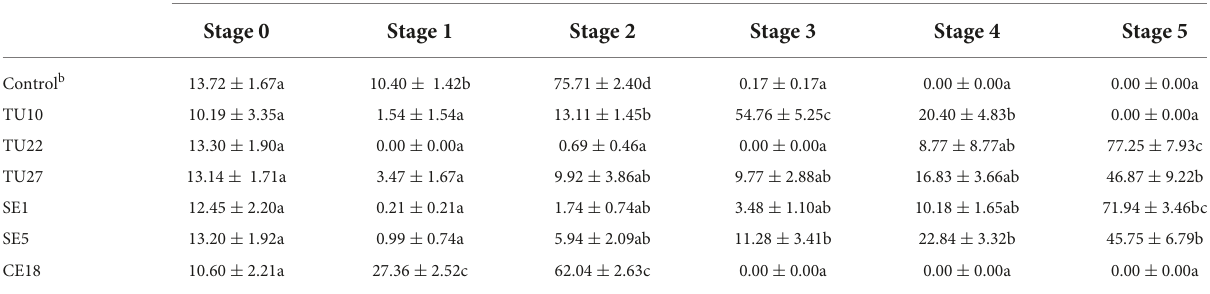
TABLE 4 Effects of fungal isolates on Dendrobium officinale seed germination and protocorm development after 3 months of culture.